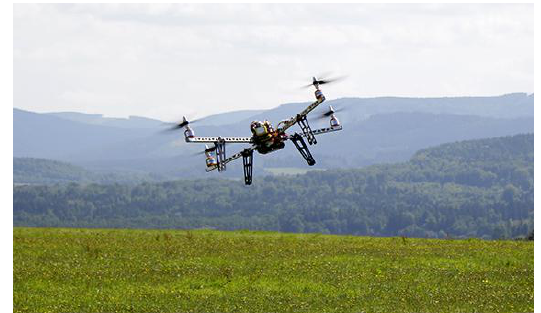
Figure 1. AGH University multirotor in operation.